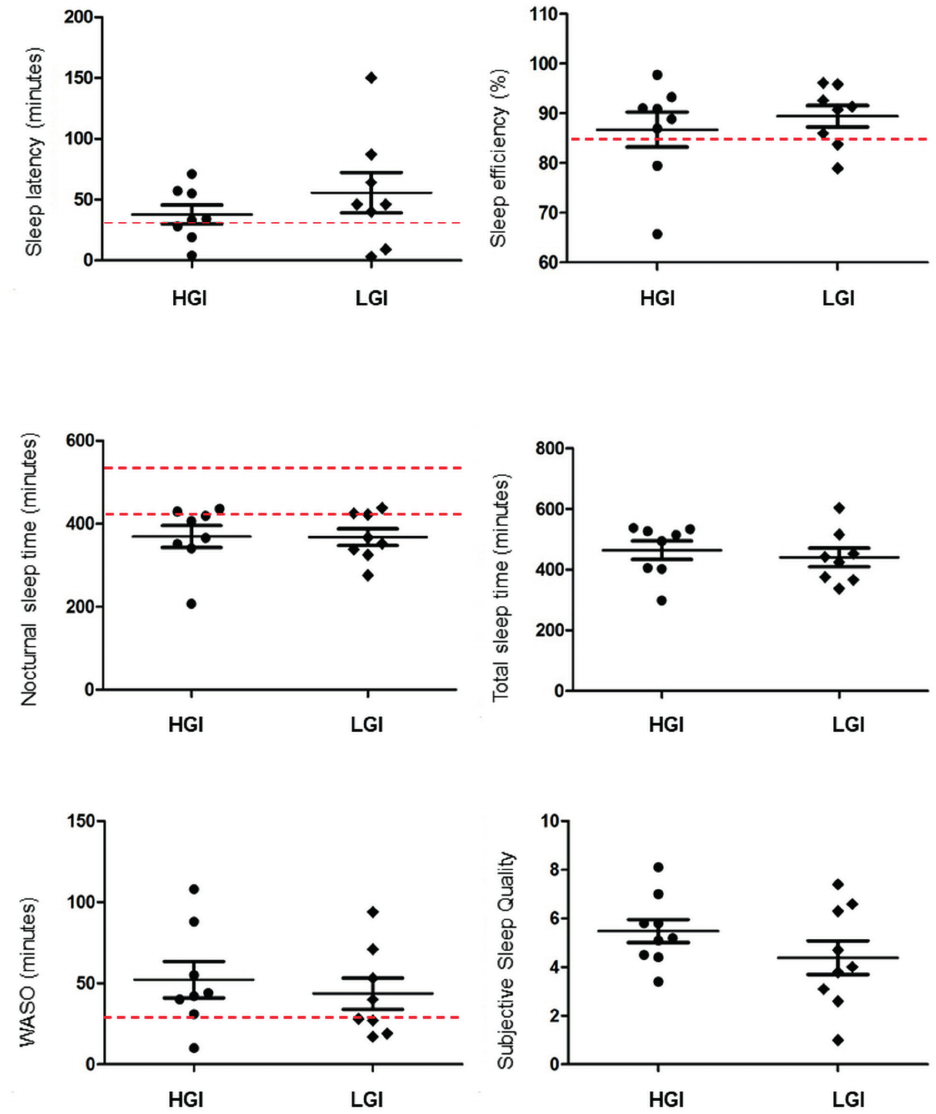
Figure 3 - Effect of different meals (HGI or LGI) on sleep (n=8). WASO=Wake After Sleep Onset. Dotted line indicates recommended values for normal adult sleep (Pinto and Silva